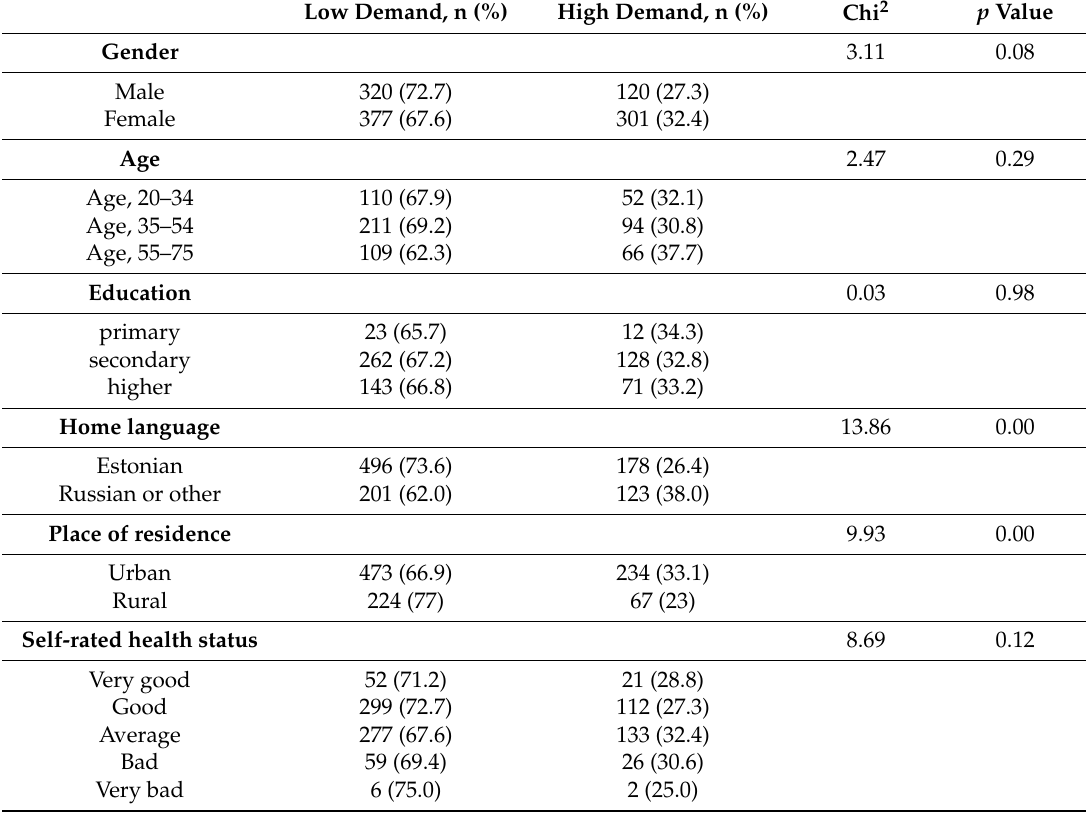
Table A2. Low and high demand for state intervention to mitigate climate change CC health effects per demographic and self-rated health, and group